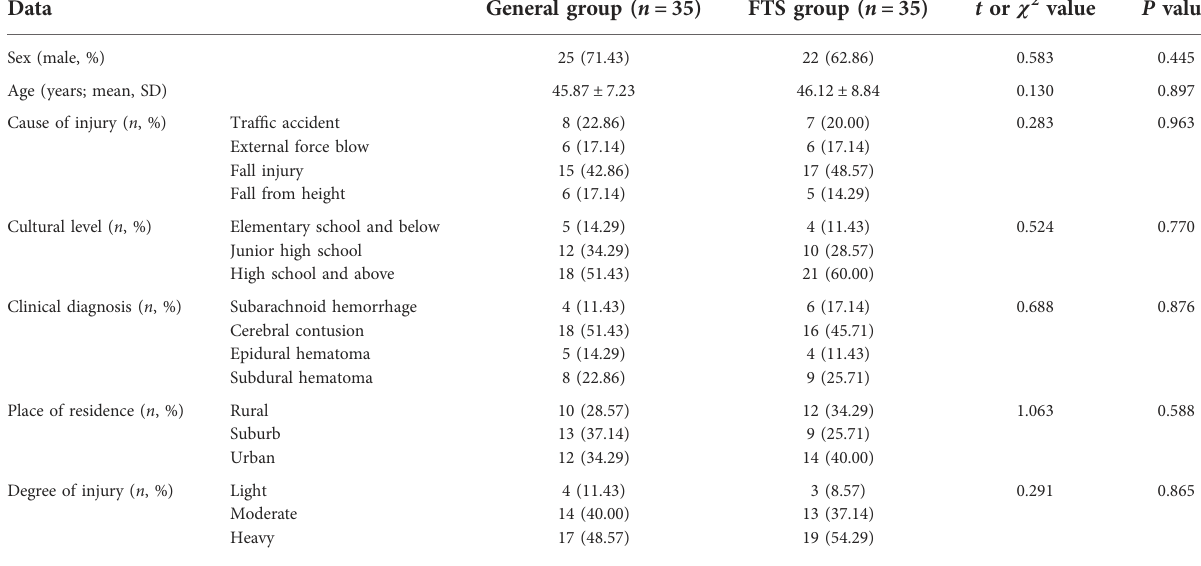
TABLE 1 Comparison of general survey data between the two groups of patients.